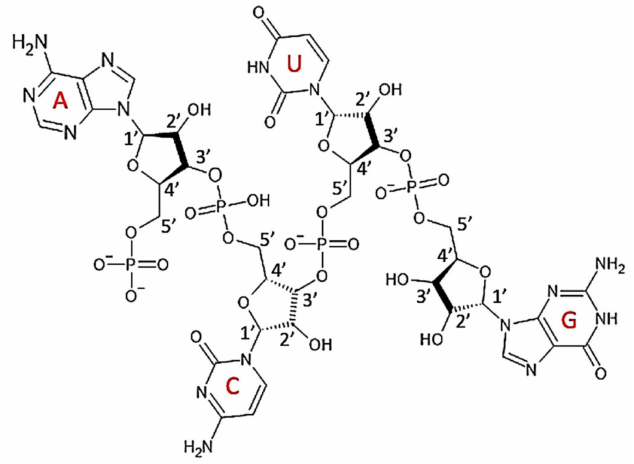
Figure 9. RNA fragment drawn using ACD/ChemSketch. Red letter represents a nitrogenous base: A—adenine, C—cytosine, U—uracil, and